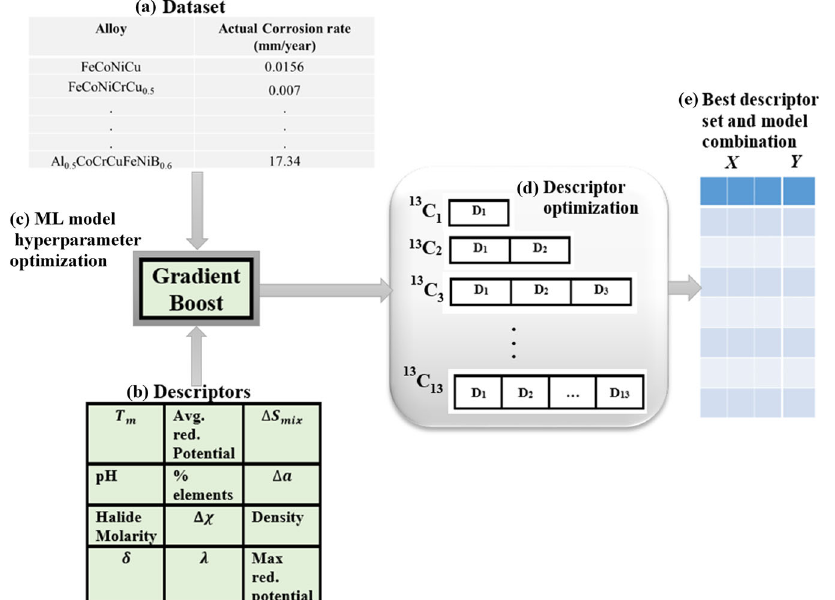
Fig. 3 Flowchart of the strategy used to obtain the best combination of ML model and descriptors for predicting the corrosion rates in MPEAs. a Composition and corrosion-rate dataset of 142 alloys was collected from the literature. b The descriptor space contained a total of 30 descriptors but down selected to 13 descriptors in stage 1 based on feature importance. c A ML model was chosen and hyperparameter optimization done to identify the best parameters with the lowest MSE. d Stage 2: an optimization technique down selected the best number and combination of descriptors from a total of 13 listed after stage 1. e The most accurate combination of the ML model and the descriptor set is then identi fi